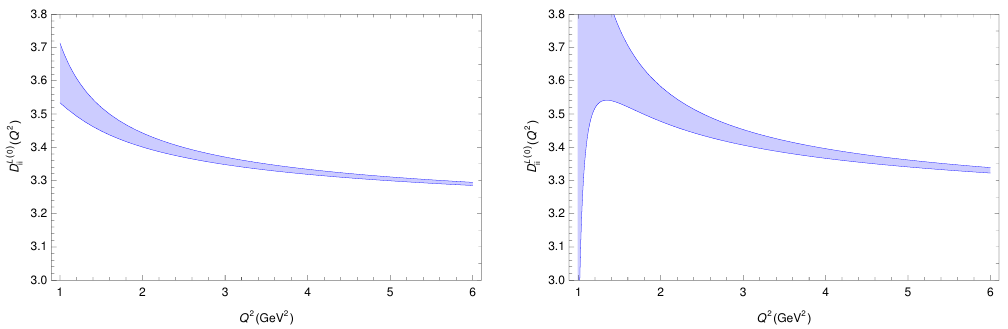
Figure 2 . Q 2 ( GeV 2 units) dependence of D L, (0) ( Q 2 ) in perturbative n f = 3 massless QCD, at ii O ( α 5 ) , for α ( n f =5) s ( M 2 ) = 0 . 115 (left) and 0 . 120 (right), including perturbative uncertainties. s Z where m ( Q 2 ) ≡ m ( n f =3) s ( Q 2 ) and the coefficients are once again shown in appendix s